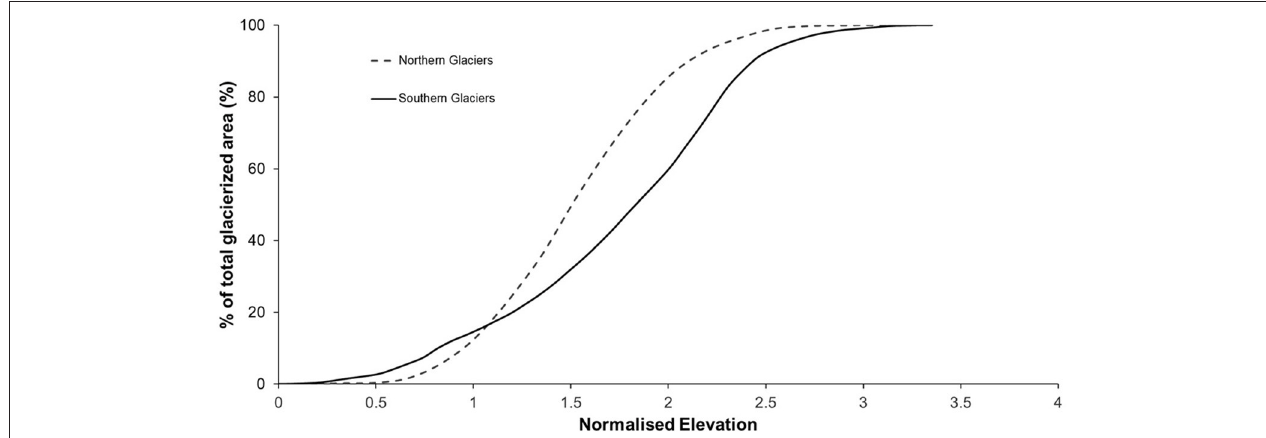
FIGURE 7 | The hypsometry of the glaciers on the Tibetan Plateau (northern glaciers) is more top-heavy than that of the glaciers in the Himalayas (southern glaciers). Note that the elevation ranges have been normalized in order to compare northern and southern glaciers.